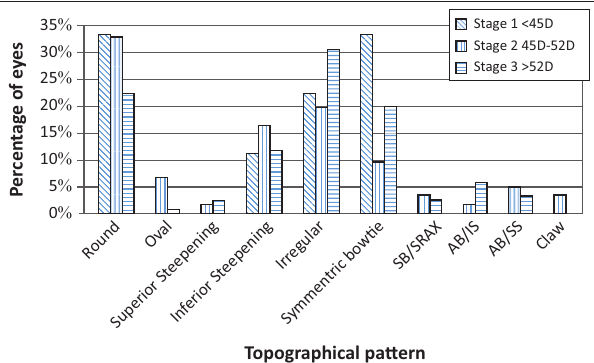
FIGURE 1: The frequency distribution of the cone locations for the various stages of keratoconus.